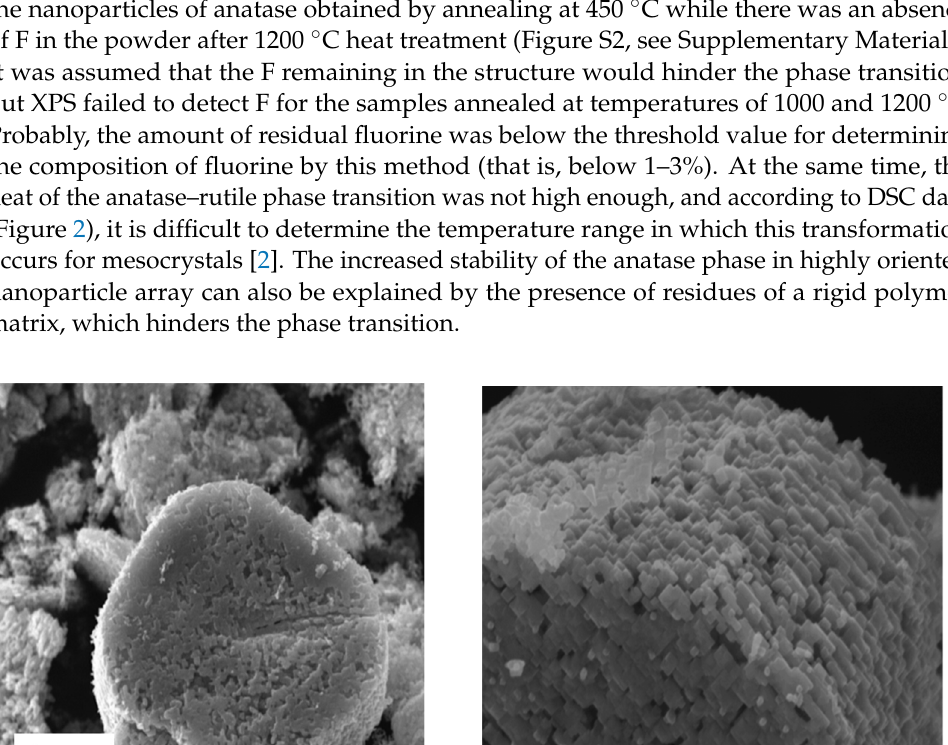
Figure 3. ( a ) XRD Patterns and ( b ) Raman spectra of TiO 2 obtained by heat treatment of ammonium oxofluorotitanate after 450, 600, 800, 1000 and 1200 °C for 2 h. Phases identity as K 2 Ti 6 O 13 (PDF #13 − 0447), anatase TiO 2 (PDF #21 − 1272), TiO 2 rutile (PDF #21 − 1276).